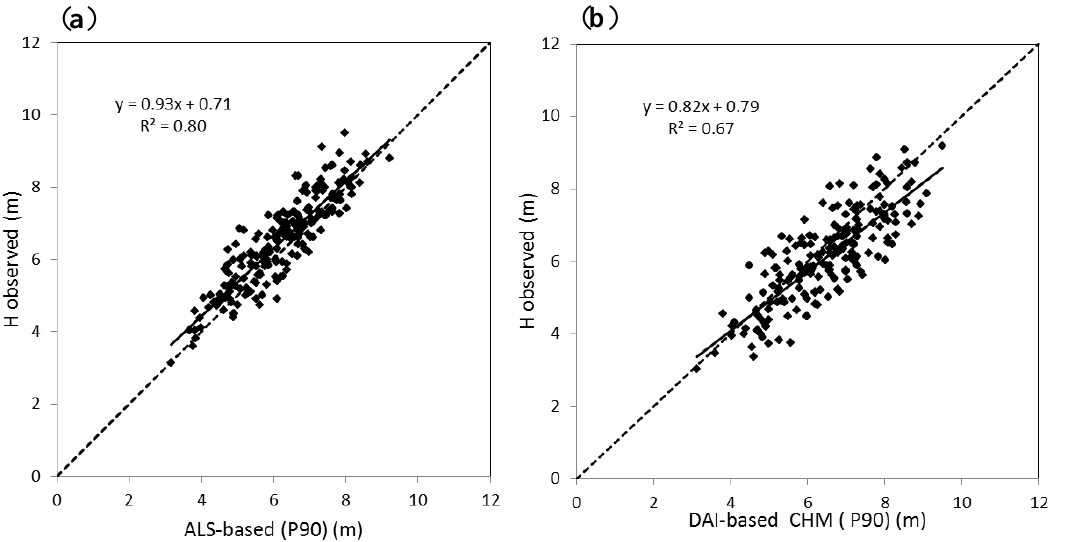
Figure 6. ( a ) Relationship between observed height and ALS-based data using the 90th percentile. ( b ) Relationship between observed height and the DAI-based data using the 90th percentile. Regression function (solid lines) and 1:1 correspondence (dashed lines). CHM, canopy height